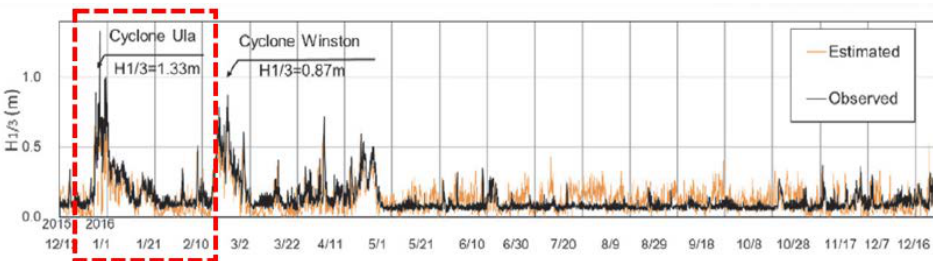
Figure 3. Wave height at the lagoon side during the monitoring